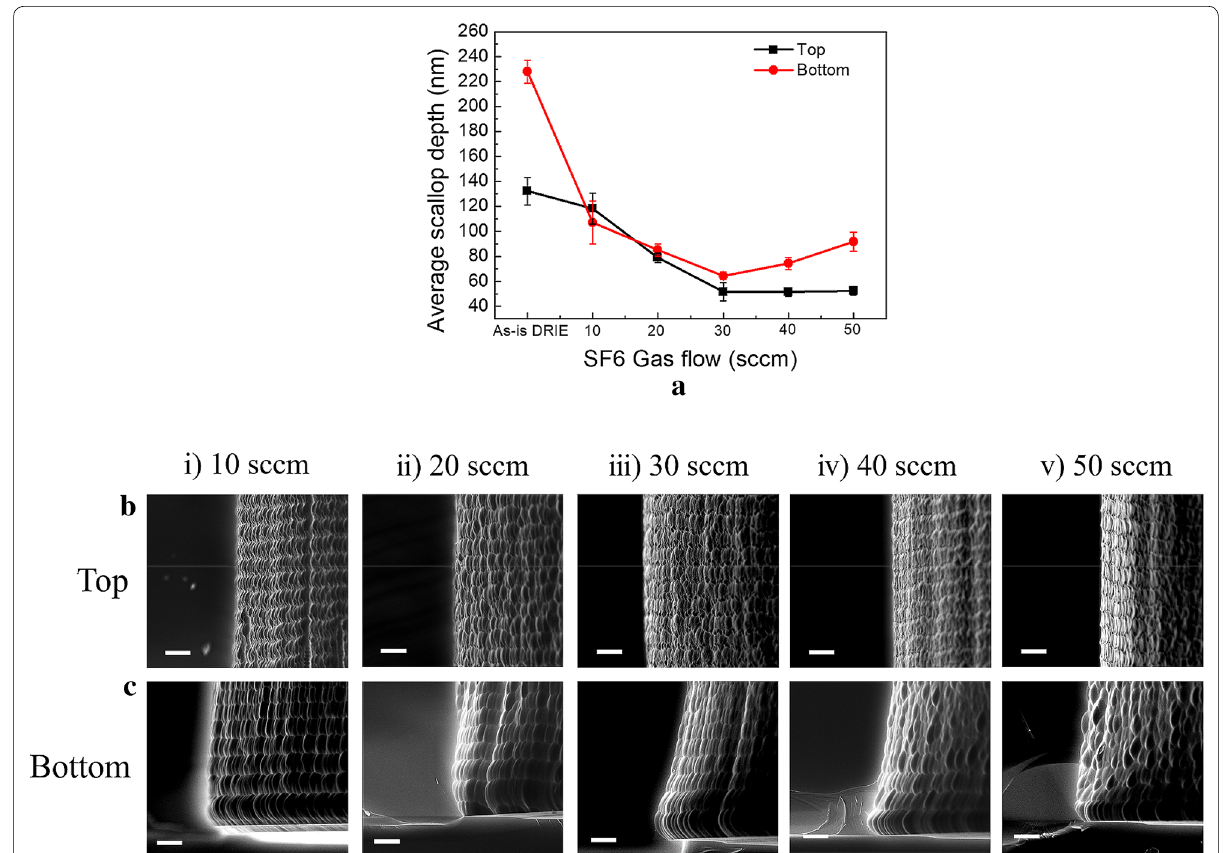
Fig. 5 Influence of the SF 6 gas flows in the scallop smooting RIE process. a Average scallop depths of trenches as a function of each SF 6 flow condition. As‑is DRIE represents the trench before scallop smoothing. The error bar under each condition represents the standard error of 5 averaged scallop depths. SEM images of sidewalls ( b ) near the top area and ( c ) at the bottom of the trenches under each SF 6 flow condition. All scale bars in SEM images are 1